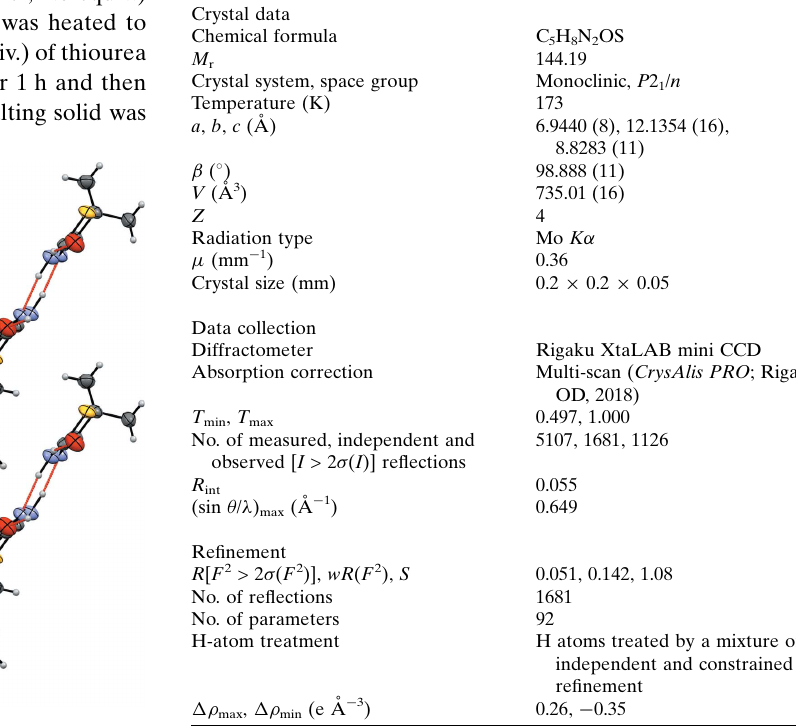
Table 2 Experimental details.